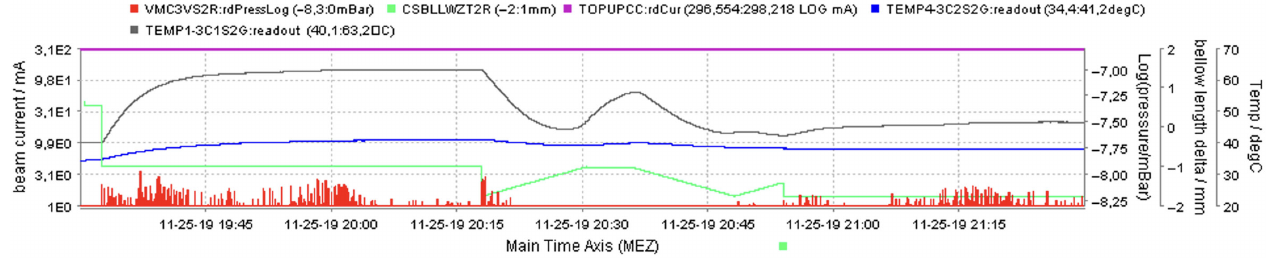
FIG. 12. Highest bellow convolution temperature (black, maximum of 63 . 2 °C, other color coding like Fig. 11) measured during the CSB1 installation time, caused by tuning the bellow to its length with the strongest vacuum activity observed previously.